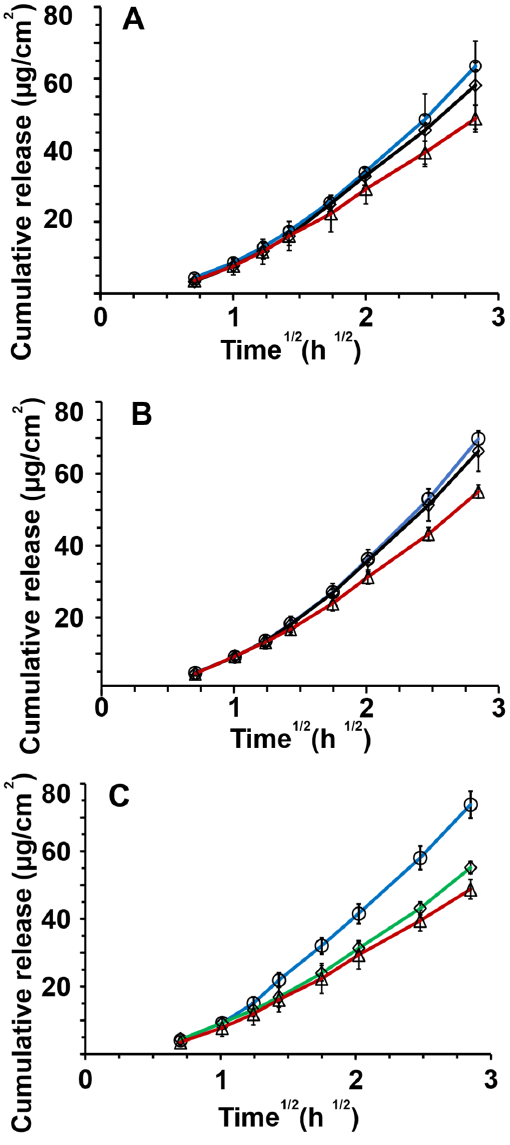
Figure 4. In vitro release of griseofulvin through nitrocellulose membranes for ( A ) hyaluronic acid, ( B ) amylopectin, and ( C ) alginic acid for different formulations: dry emulsion powders, redis- persed dry emulsions, and emulsions. The release data and standard deviations are presented as a linear fit against the square root of time according to the simplified Higuchi equation ( n = 4).